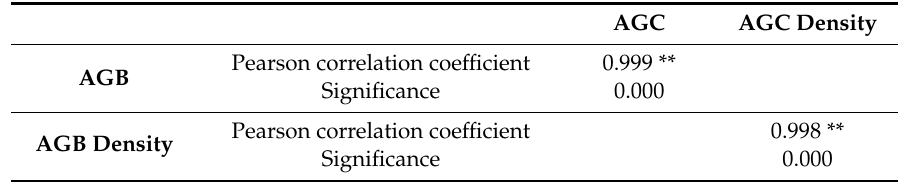
Table 9. Correlation coe ffi cients between aboveground biomass (AGB) (AGB density) and aboveground carbon (AGC) (AGC density).